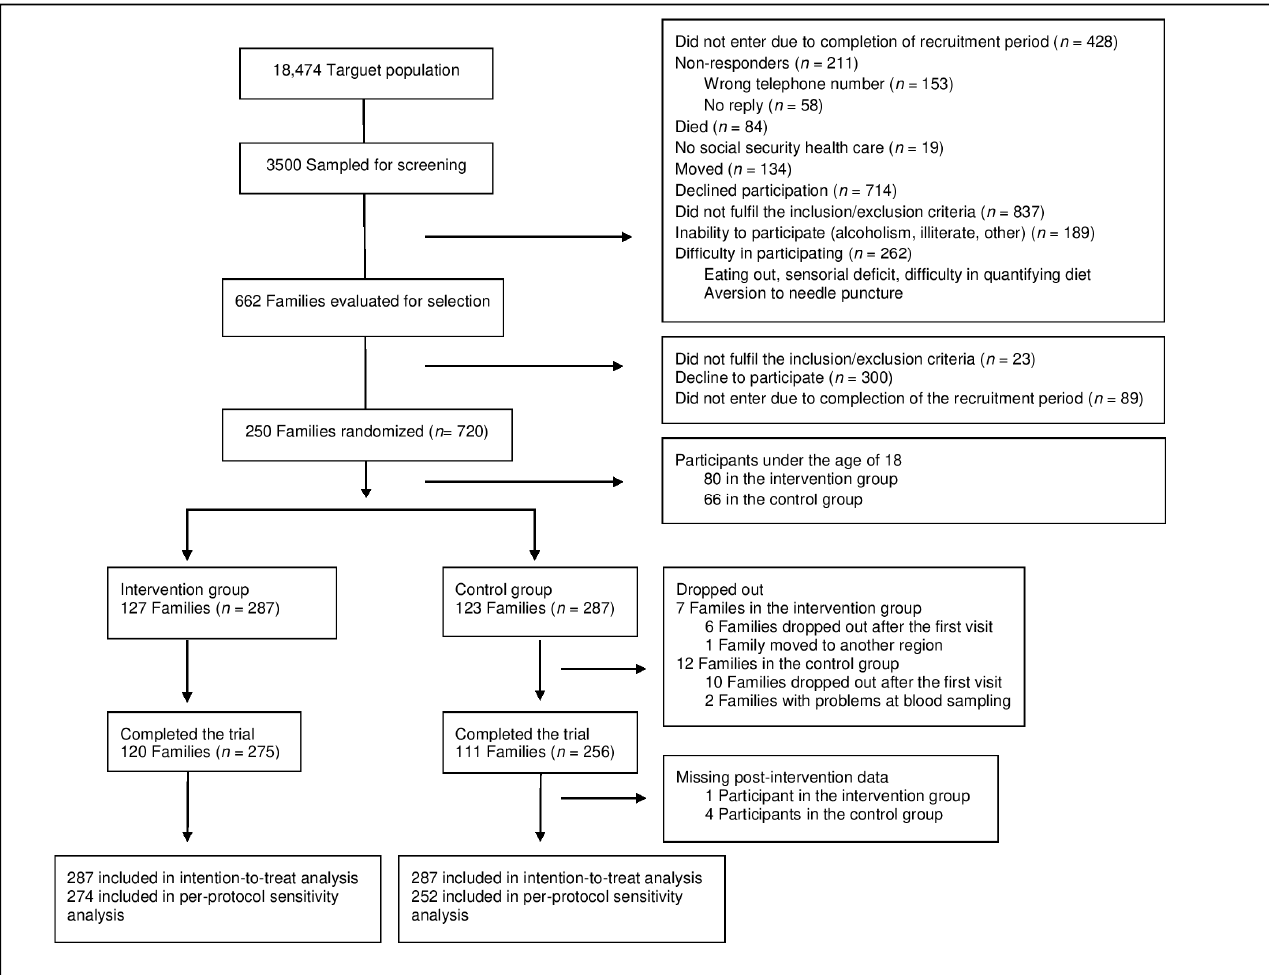
Figure 2. Overview of the study population. Table 2. Baseline characteristics of the study participants (intention-to-treat data set). Study Sample